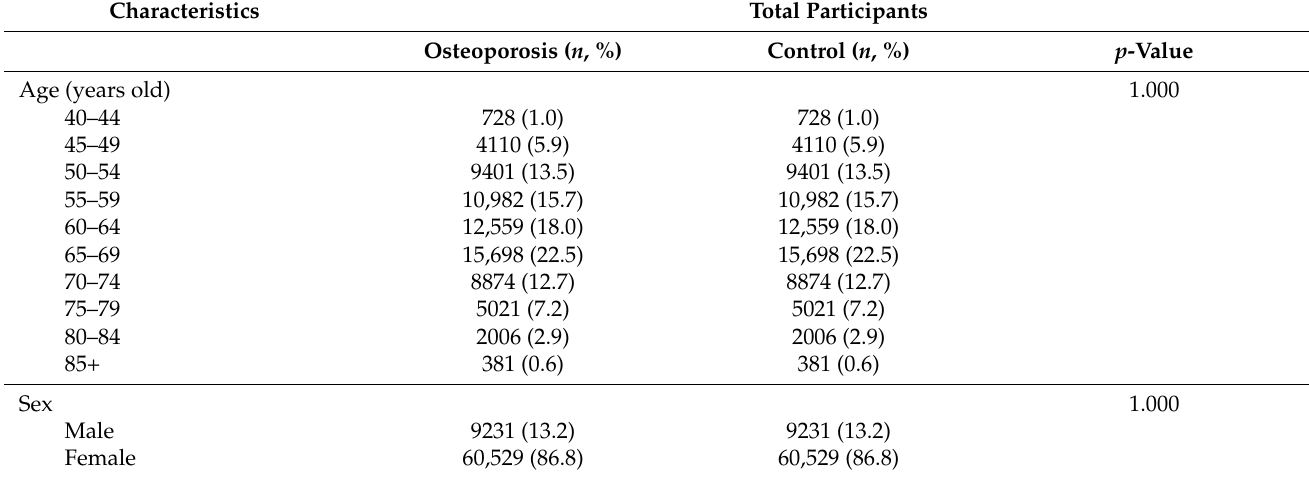
Table 1. General characteristics of